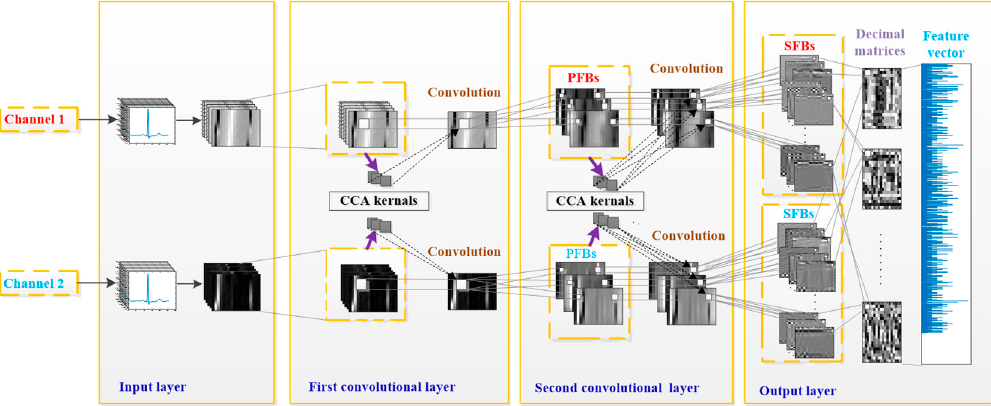
Figure 2. The structure of the DL-CCANet.